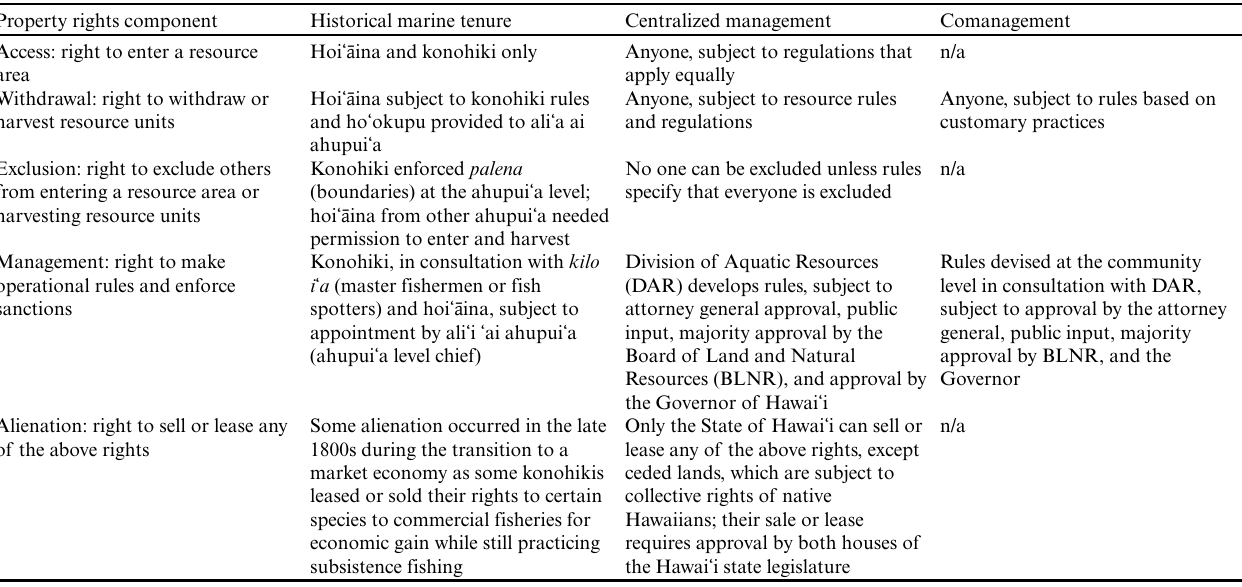
Table 5. A comparison of historical customary marine tenure and comanagement institutional arrangements in Hawai ʻ i (property rights). Framework adapted from Schlager and Ostrom